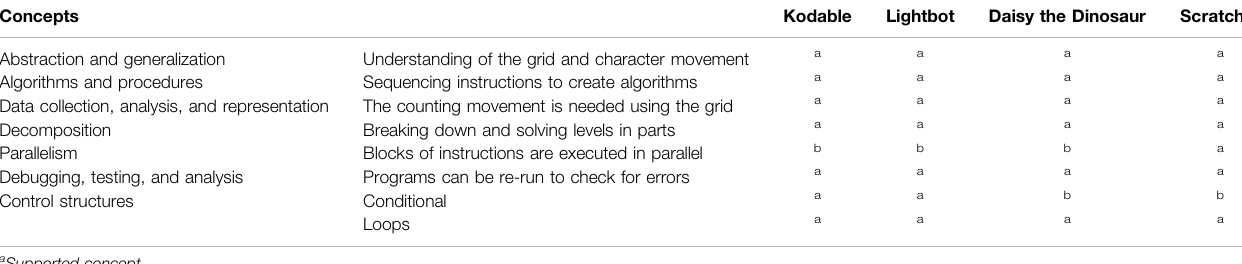
TABLE 3 | The computational thinking concepts supported in Kodable, Lightbot, Daisy the Dinosaur, and the ScratchJr. Concepts